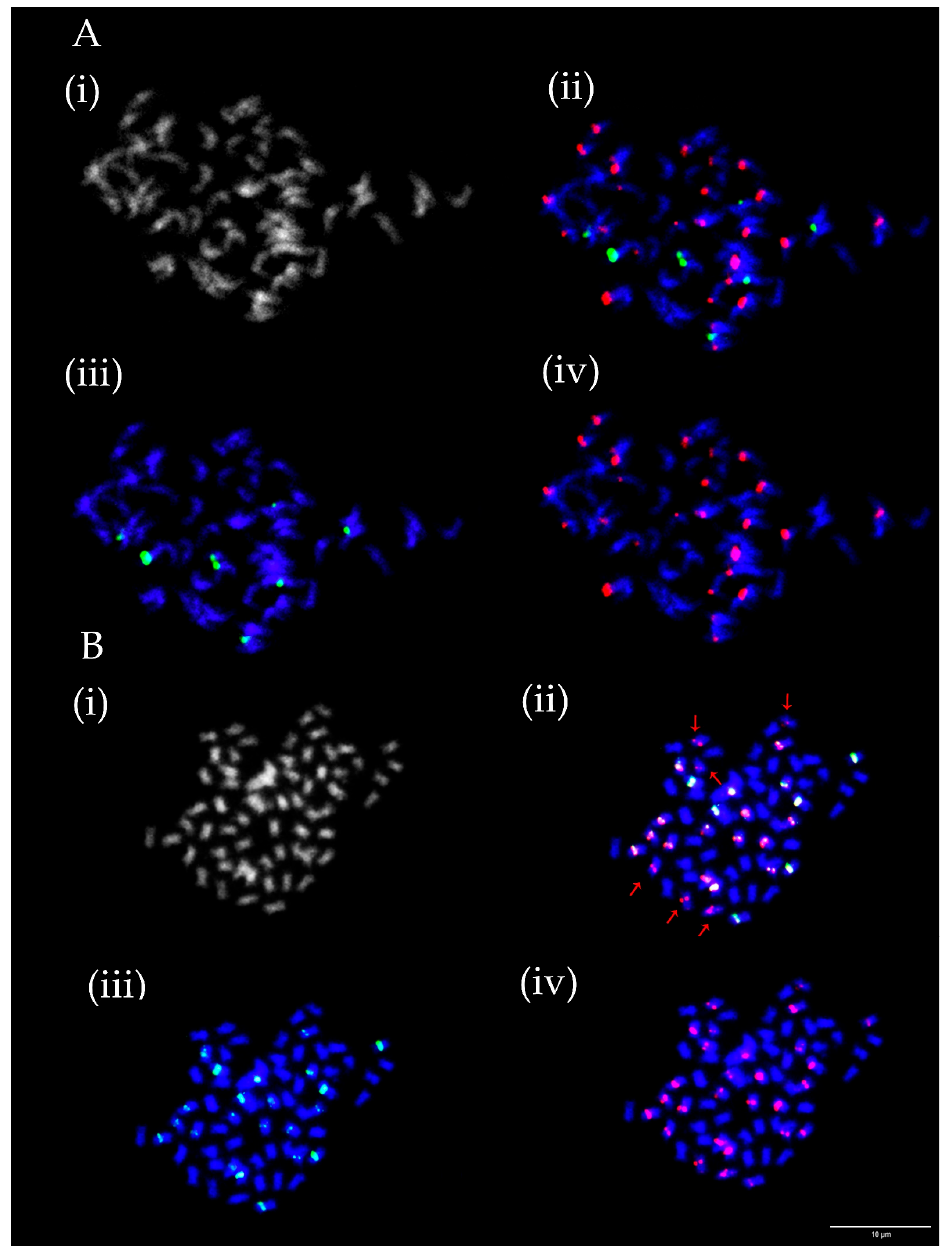
Figure 3. Numbers and localization of TrM378 (red) and TrM300 (green) loci on chromosomes of two T. medium ecotypes. ( A ) T. medium ecotype 2 with 16 TrM378 and 10 TrM300 loci, all separated on different chromosomes. ( B ) T. medium ecotype 5 with 28 TrM378 and 22 TrM300 loci with all TrM300 loci co-localized with TrM378 loci. Four pictures are presented for each ecotype including